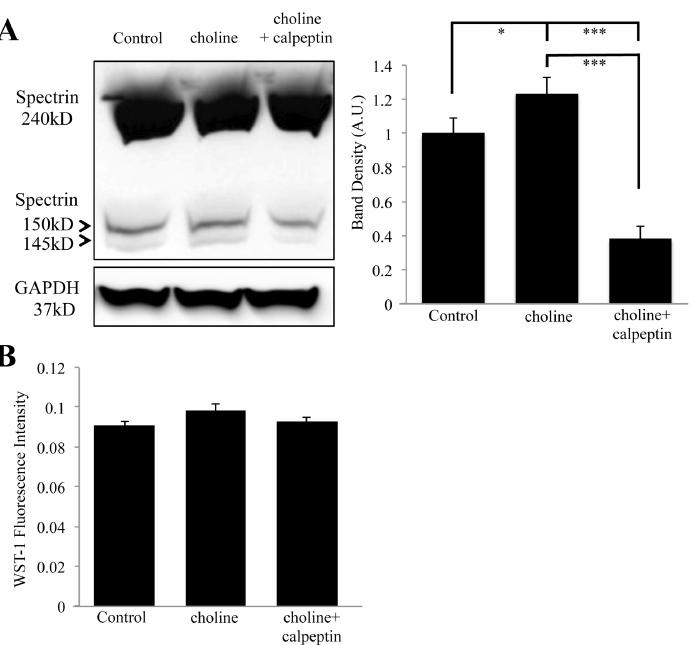
treated with 10 mM choline, 26 μ M calpeptin and choline, or HBSS (Control). Right, band density analysis from three independent experiments showing an effect of choline on the α IIspectrin breakdown. Band density was calculated by combining the density of the 150 kD and the 145 kD spectrin breakdown bands. (B) WST-1 fluorescence showing cell viability during drug treatments ( (cid:3) = p < 0.05, (cid:3)(cid:3)(cid:3) = p < 0.001; n = 3 independent experiments).